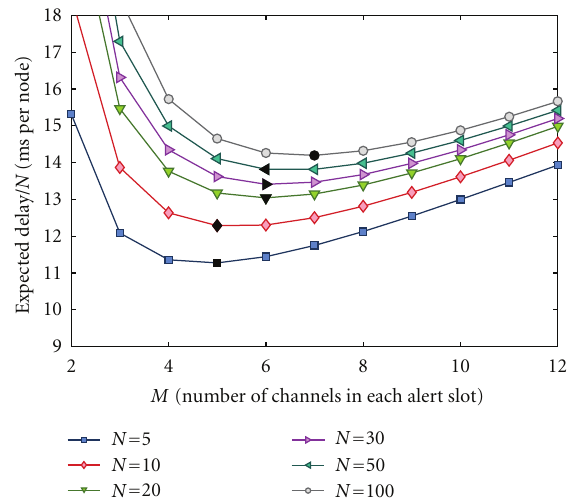
Figure 6: Normalized delay (ms per node) versus number of chan- nels in each Alert